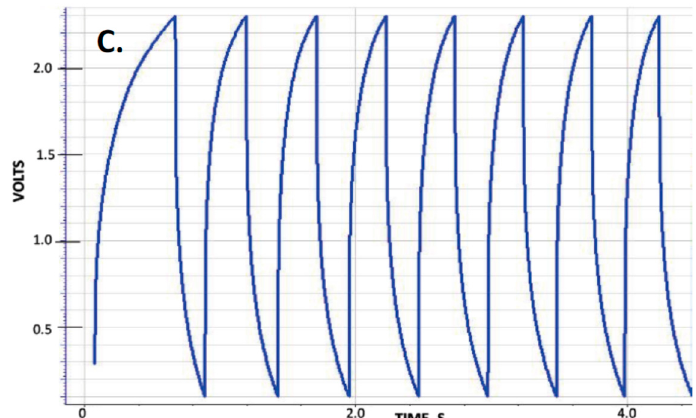
Figure 1. Five Layers of Nylon Cycles: ( A ) 12 mA, DT ~ 54 s showing one cycle, and illustrating three voltage regions; ( B ) 12 mA, DT ~ 54 s, 7 cycles; and ( C ) 90 mA, DT ~ 0.25 s, 7 cycles. As shown, the first ~3 cycles collected at any current value are “not typical” and not used in computation. Note: Data were collected on the basis of the smaller of these two values, 0.01 volts or 0.01 s, in all cases. (The plotting routine for this figure lumped data to approximately one value every 0.5 s.)